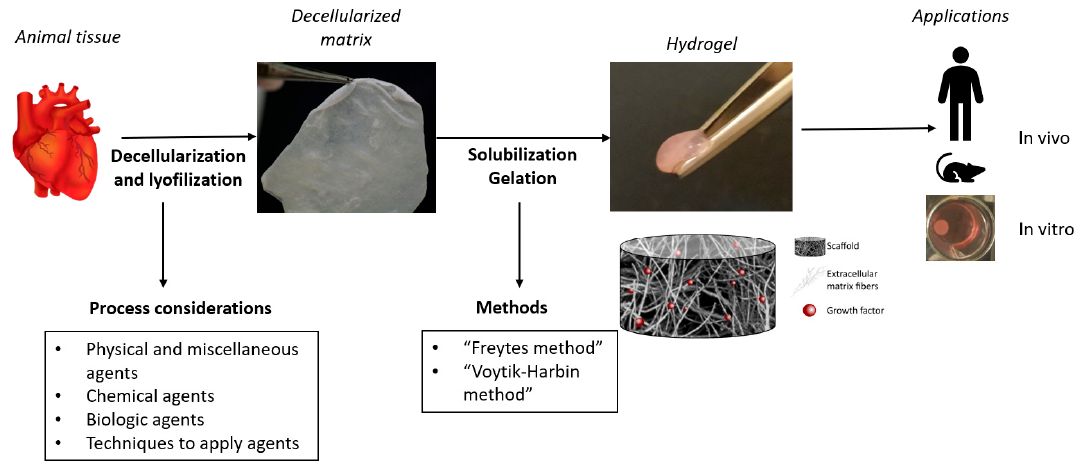
Figure 4. Decellularized ECM hydrogel’s process obtention.